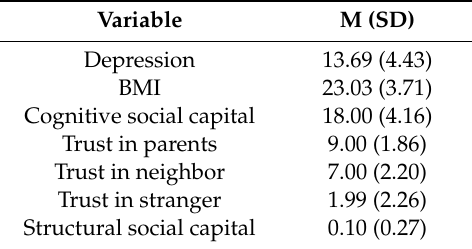
Table 2. Mean scores of key variables for the total sample.